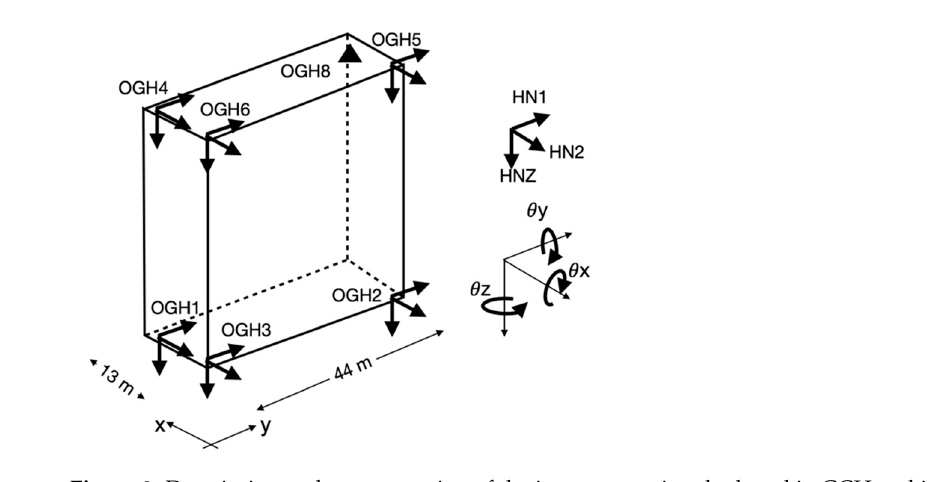
Figure 2. Description and representation of the instrumentation deployed in GCH and identification of the translation and rotation components.